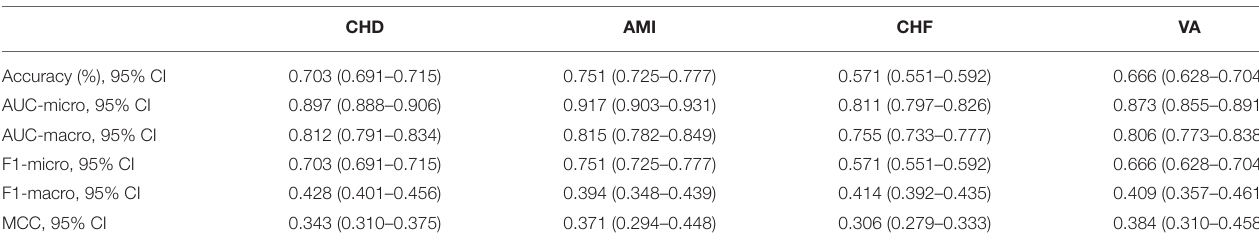
TABLE 4 | Performance of the XGBoost model in the four major types of heart